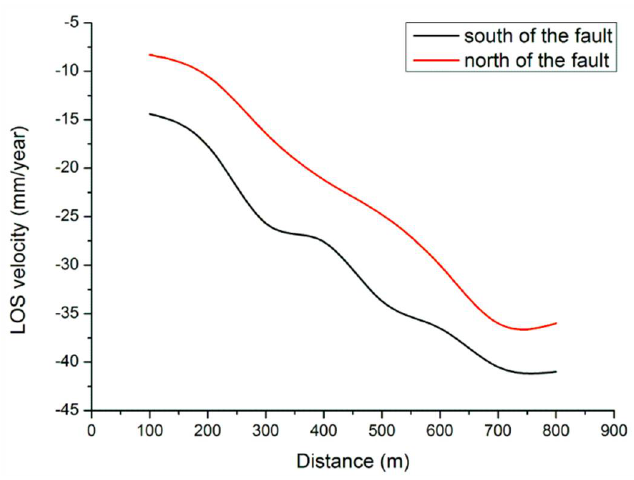
Figure 19. The subsidence rate on both sides of the F3 fault (from northwest to